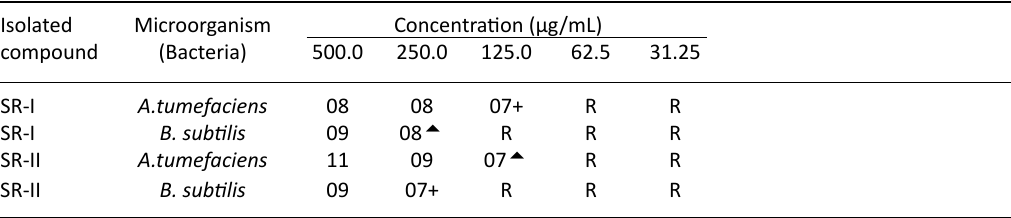
Table 2. The MIC/MBC data of isolated compounds Isolated Microorganism Concentration (µg/mL) compound (Bacteria)